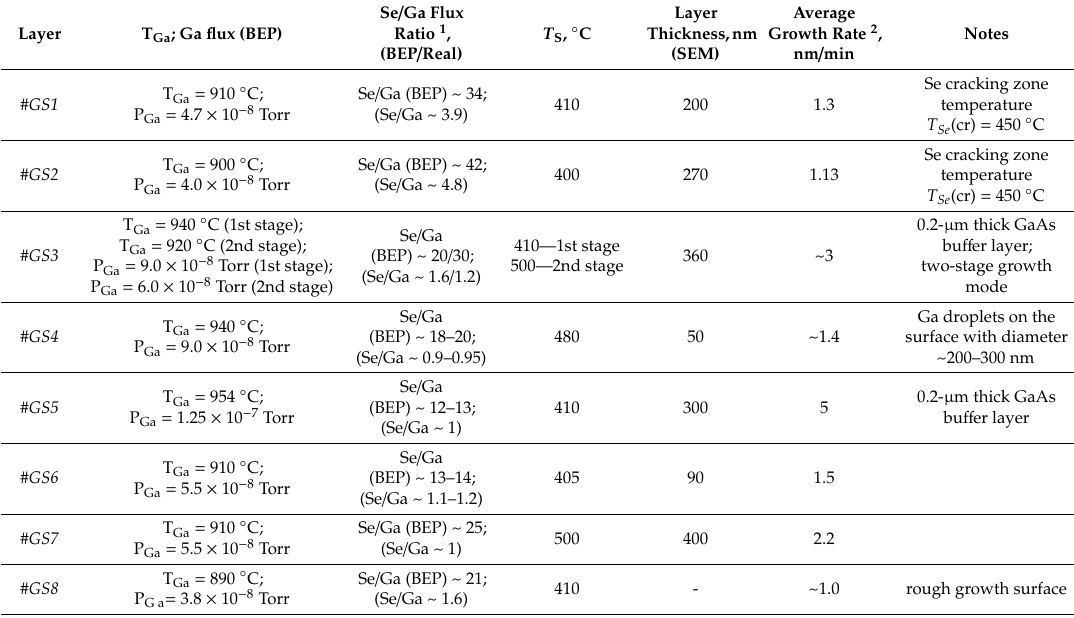
T Ga = 900 ◦ C; Se / Ga (BEP) ~ 42; P Ga = 4.0 × 10 − 8 Torr (Se / Ga ~ Table 1. The growth parameters of GaSe/GaAs(001) layers.